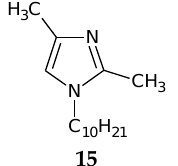
Figure 6. The 1-decyl-2,4-dimetylimidazole molecule.